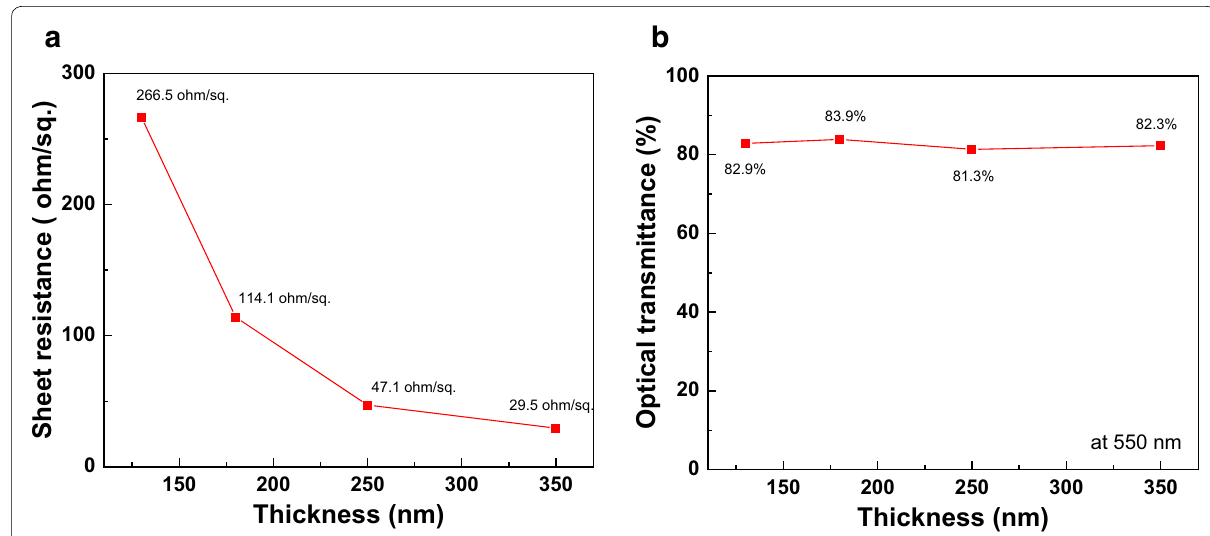
Fig. 6 a Sheet resistance and b optical transmittance of ITO layers by sputtering with reused ITO target dependent on film